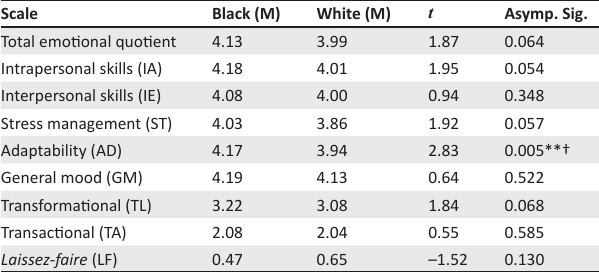
TABLE 6: Significant differences between race groups: t -test. Scale Black (M) White (M) t Asymp.